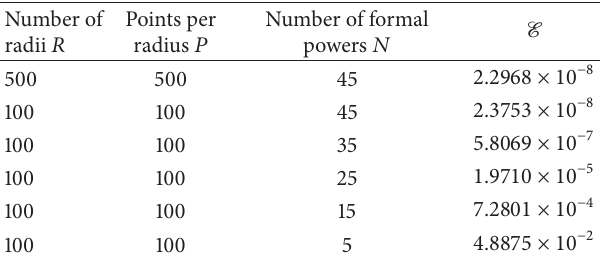
Table 2: Relation between the error E and the number of formal powers, for the case when 𝜎 has a Lorentzian